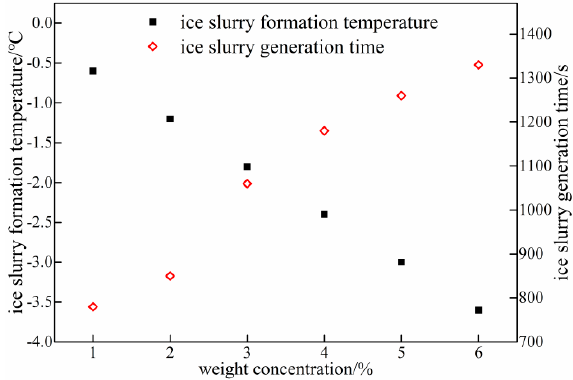
Figure 5. Ice slurry formation characteristics at different initial NaCl concentrations.